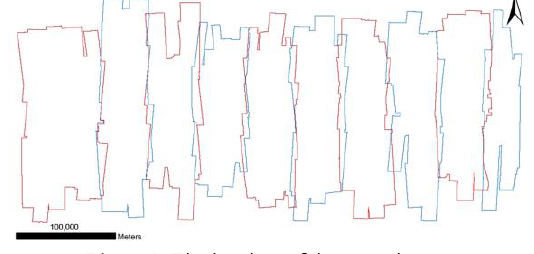
Figure 3. The borders of the ten subareas